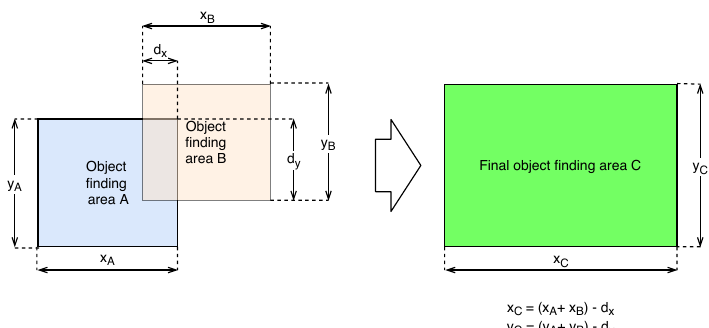
Figure 22. Illustrations describing the unification of the intersecting objects found into the final object.